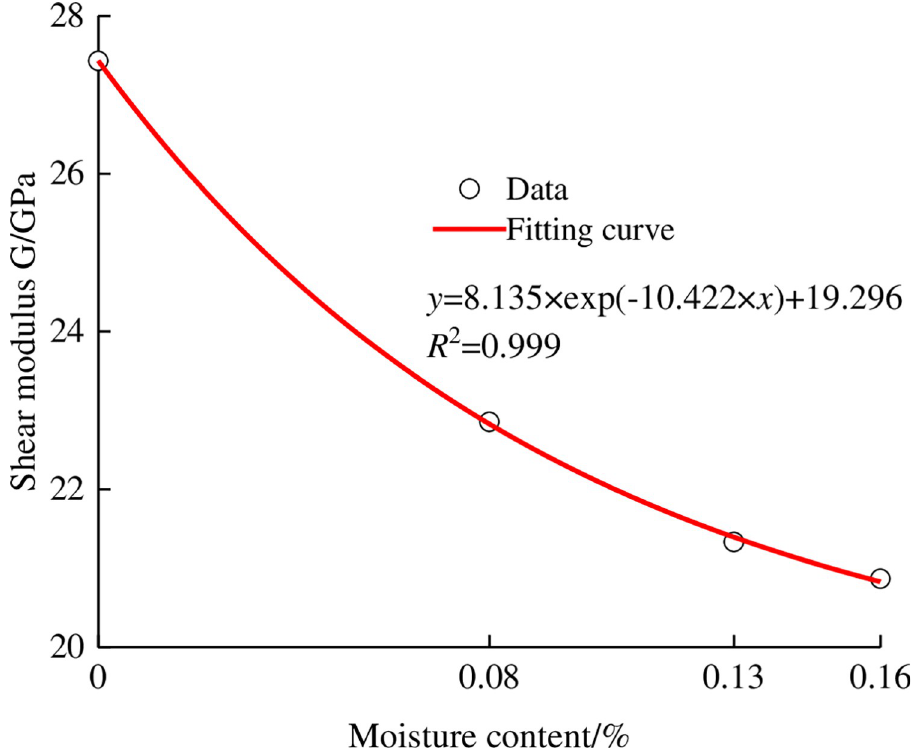
Fig 9. Change curve of the shear modulus of the anchorage rock mass under different water contents.